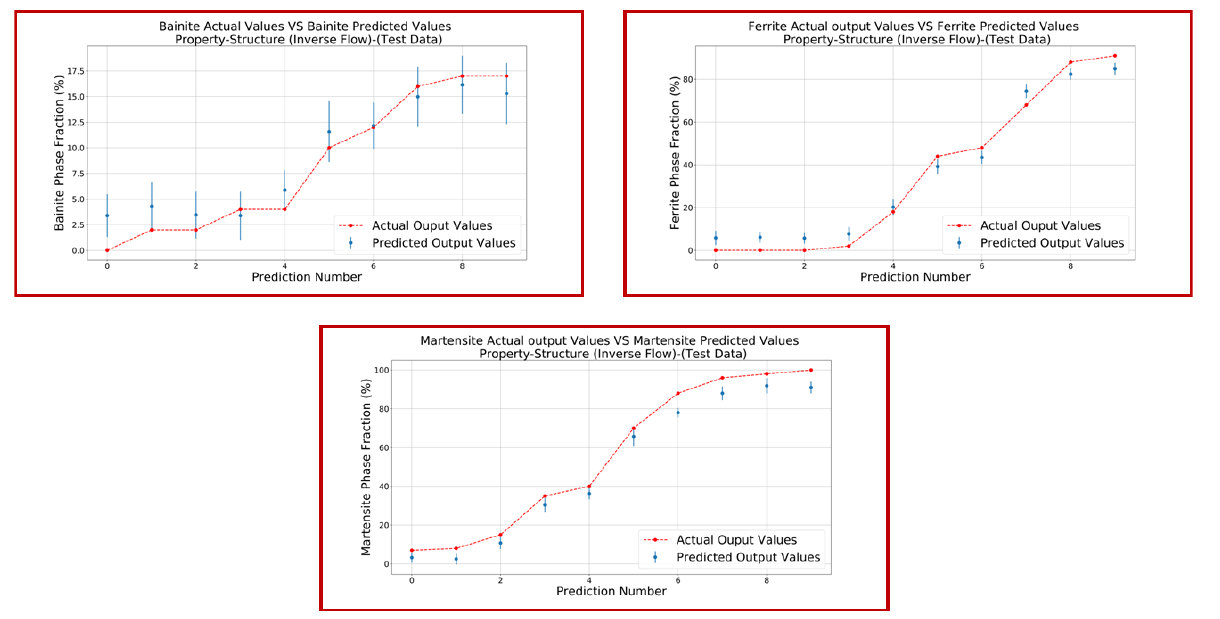
Figure 8. Predicted Output and Actual Output Comparison for Step 2 (For Test Dataset).